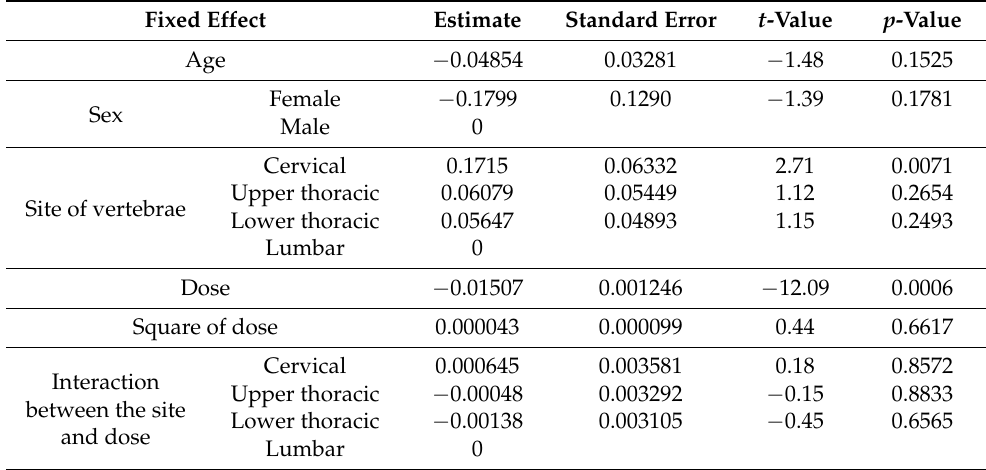
Figure 4. Relative growth rate of vertebral bodies compared with the control for each patient. Each line represents each patient and the vertical axis shows the ratio of the growth rate to out-of-field vertebral bodies. Table 1. Result of the fixed effects estimation with a best-subset